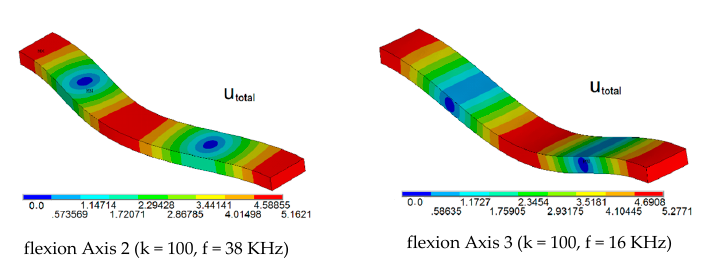
Figure 7. Results using the Sorohan et al. [25] SAFE method, the dispersion curves and the displacement field of each mode. Notice that in this graph the wave number is defined as k = 2 π / λ [m - 1